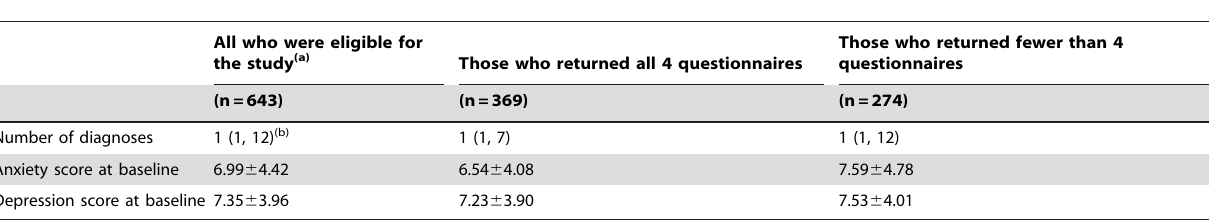
All who were eligible for the study